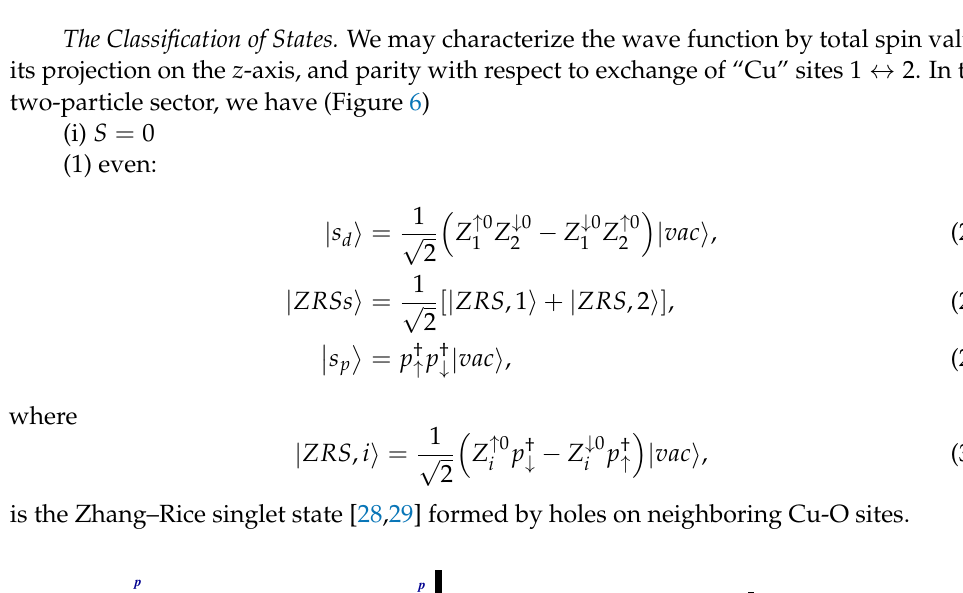
Figure 5. Energy level scheme in a “Cu-O-Cu” molecule.